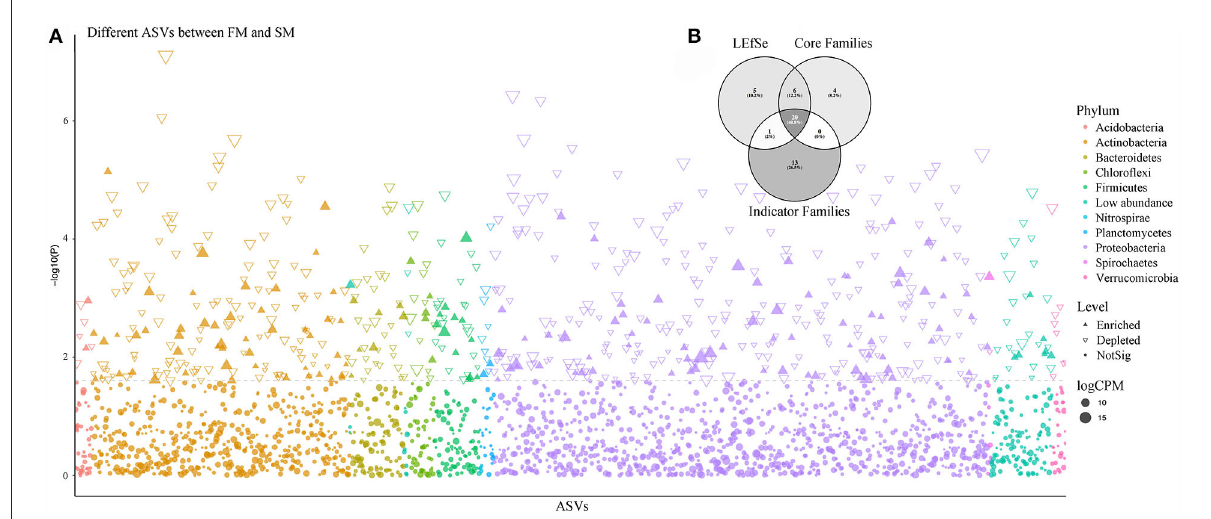
FIGURE3 The comparison of core bacterial microbiota predicted by different methods. (A) Manhattan plot showing different ASVs enriched in FM and SM. Each dot or triangle represented a single ASV. ASVs enriched in Moso bamboo soil bacteria are represented by filled or empty triangles, respectively (FDR adjusted P < 0.05, Wilcoxon rank sum test). ASVs are arranged in taxonomic order and colored according to the phylum. CPM, counts per million. (B) The comparison of Moso bamboo core bacteria generated by indicator Families, core Families, and LEfSe via Venn